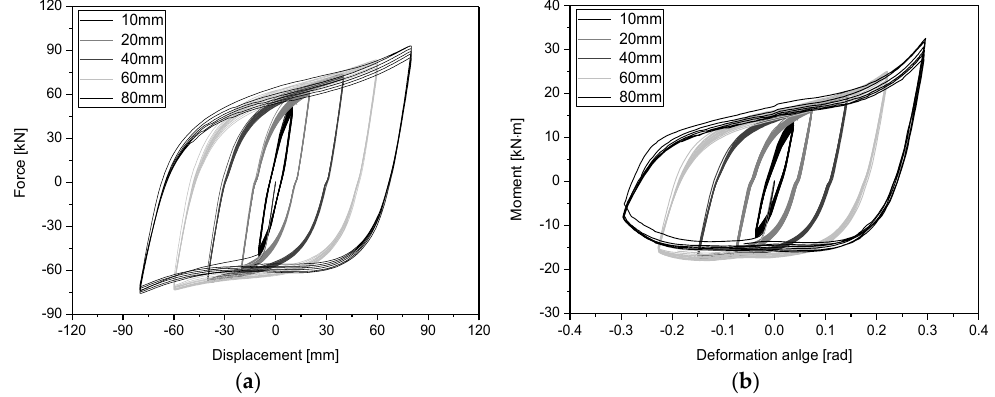
Figure 5. Hysteresis loop for force–displacement (P–D) and moment–deformation angle (M–R) relationships: ( a ) P–D; ( b )